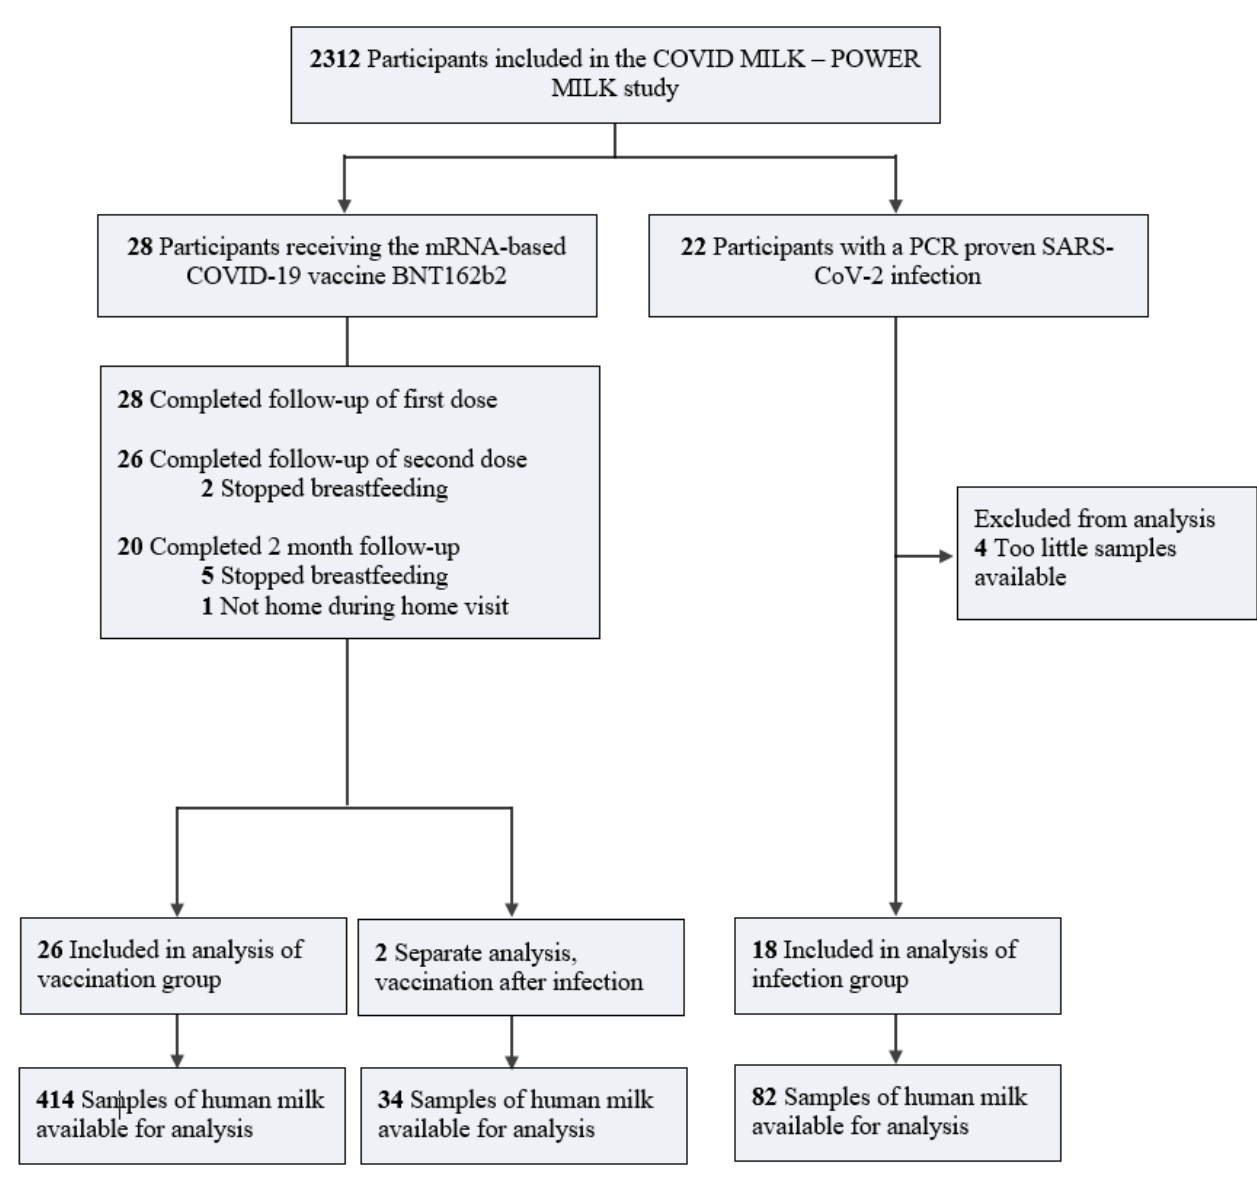
Figure 1. Flow diagram of lactating women participating in this study. BNT162b2 indicates a COVID-19 vaccine; mRNA, messenger ribonucleic acid; PCR, polymerase chain reaction; SARS-CoV-2, severe acute respiratory syndrome coronavirus 2.